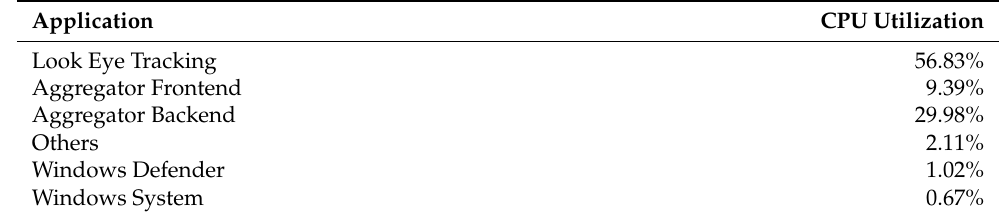
Table 4. Average CPU utilization of the Aggregator Device by